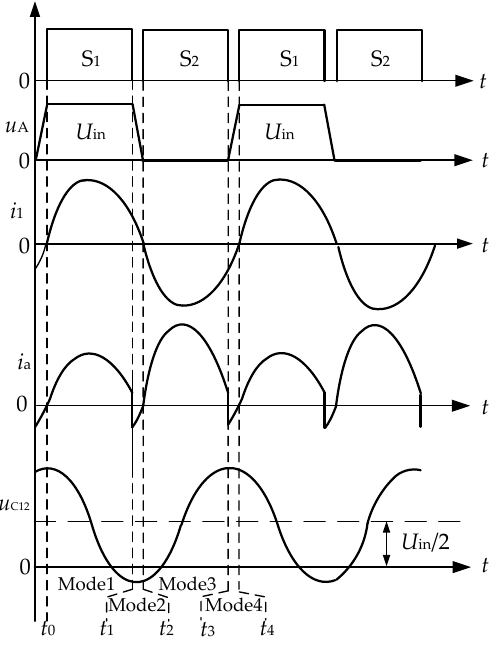
Figure 3. Operational waveforms of SHRC.